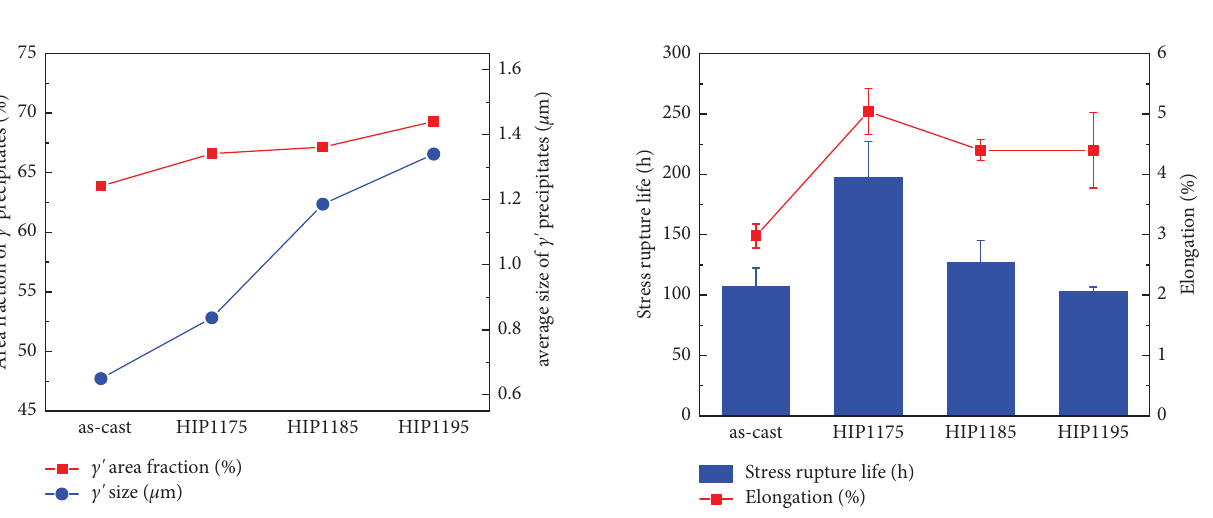
Figure 8: Stress rupture properties of K417G alloy in diferent conditions at 760 ° C and 645MPa.